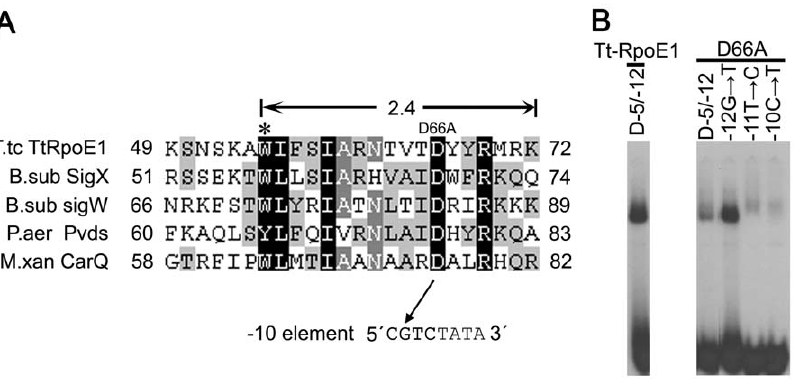
Figure 7. The effects of single amino acid substitution in Region 2.4 of Tt-RpoE1 on the interaction between Tt-RpoE1 and promoter DNA. ( A ). Alignment of the amino acid sequence of Regions 2.4 in group IV ECF s factors. The numbers at each end of the sequence indicate the amino acid position. The substitutions in Tt-RpoE1 used in this study are shown. The asterisk indicates the conserved amino acids of the melting residues of s 70 . Species abbreviations and GenBank accession numbers of their proteins are as follows: Thermoanaerobacter tengcongensis (T.tc), Tt-RpoE1 (NP_622011.1); Bacillus subtilis (B.sub), SigX (NP_390191.2), SigW (NP_388054.1); Pseudomonas aeruginosa (P.aer), PvdS (NP_251116.1); Myxococcus Xanthus (M.xan), CarQ (YP_632266.1). The recognition between D66 and 2 12G is indicated by arrow. ( B ). The effects of single amino acid substitution in Region 2.4 of Tt-RpoE1 on the interaction between Tt-RpoE1 and wild-type (D 2 5/ 2 12) or mutated promoter DNA. Tt-RpoE1 D66A uniquely suppressed single nucleotide changes at position 2 12G.